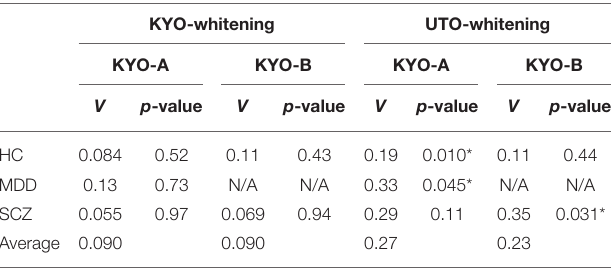
TABLE 6 | Differences of clustering results (clusters 1–4 in view 4) between the discovery and validation data based on the χ 2 test.